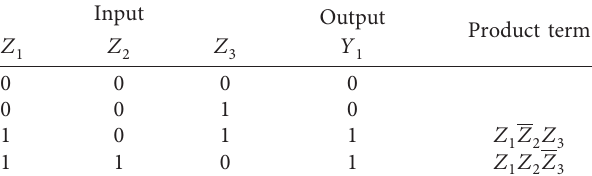
Table 1: Example of listing the operation of an implicit memory.